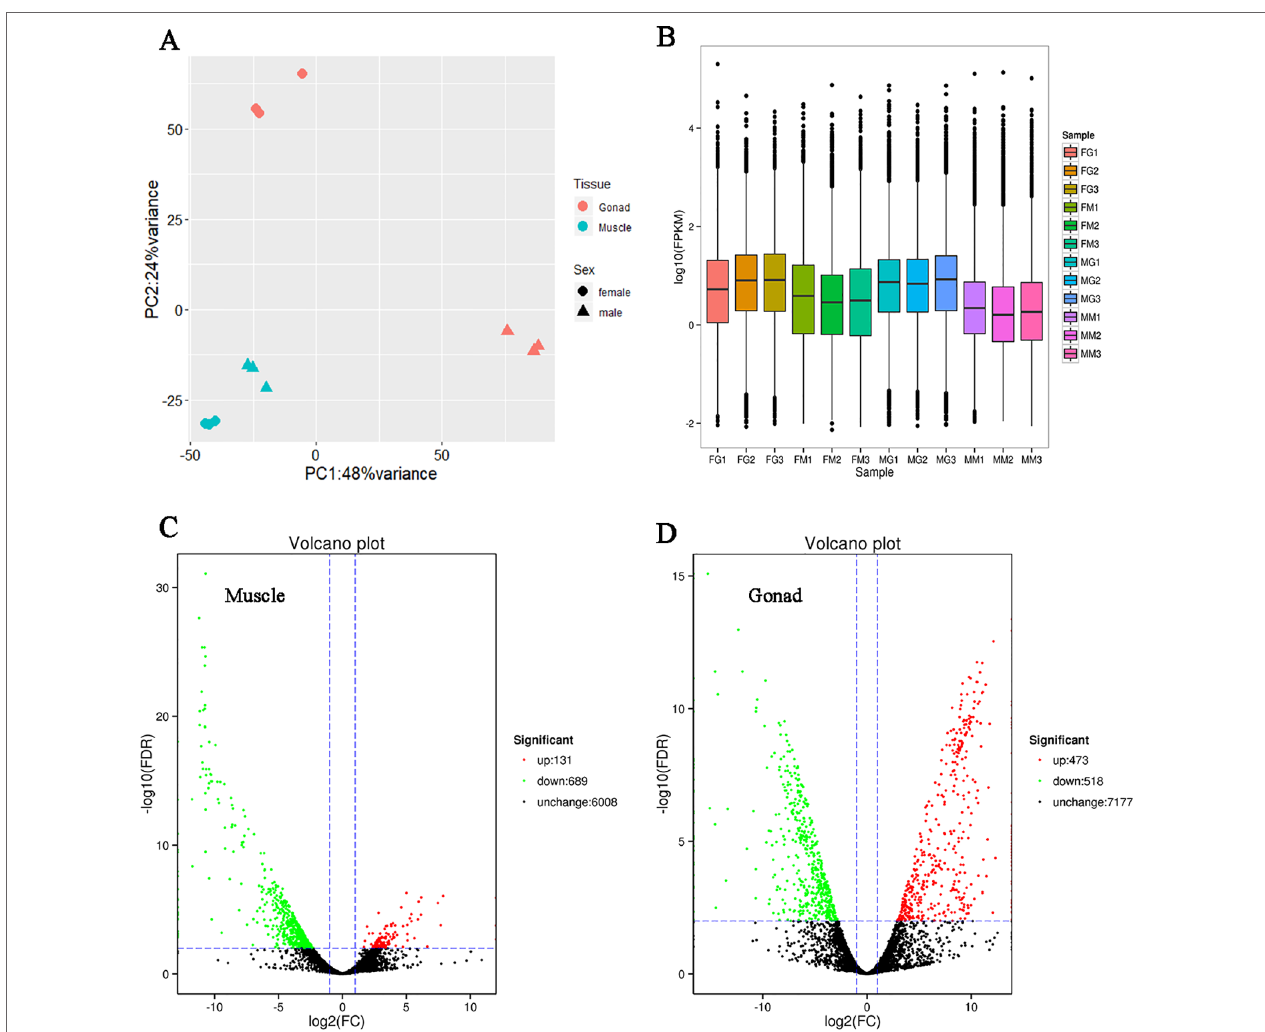
FIGURE 1 | Expression profile reflected by the short reads RNA sequencing data. (A) Principal component analysis of the 12 samples. Each point represents one sample, with shape indicating sex, and color indicating tissue. (B) Boxplot of the fragments per kilobase of transcript per million fragments mapped (FPKM) distribution of each sample. The abscissa represents different samples. The first letter of the sample name represents sex (the “F” means female, and “M” means male). The second letter of the sample name represents tissue (the “G” means gonad, and “M” means muscle). The number of the sample name represents the different individuals in the same group. The ordinate represents the logarithm of the sample expression FPKM. The graph measures the expression level of each sample from the perspective of the overall dispersion of expression quantity. The last two charts were expression volcano plot of differentially expressed transcripts (DETs) in muscle (C) and gonad (D) . Each point presents a transcript. The abscissa represents the logarithm of the expression fold change of male relative to female. A larger absolute value indicating a larger expression difference between the male and female. The ordinate represents the negative logarithm of the statistical significance of the expression difference. The larger value indicating the more significant expression difference between male and female, and the better reliability of the screened DETs. The red dots represent up-regulated DETs, the green dots represent down-regulated DETs, and the black dots represent